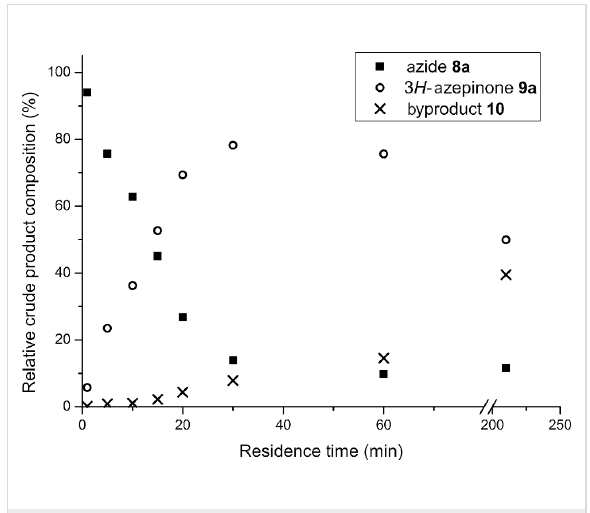
Figure 1: Relationship between residence time and relative compos- ition of the crude reaction mixture.